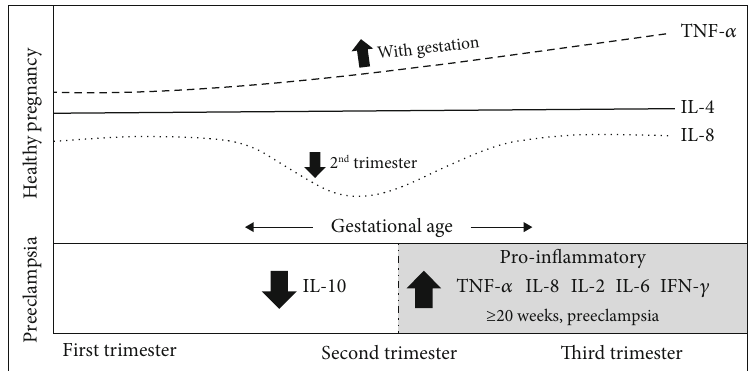
Figure 2: An illustration summarising the changes in the maternal serum cytokine pro fi le in healthy pregnancy and